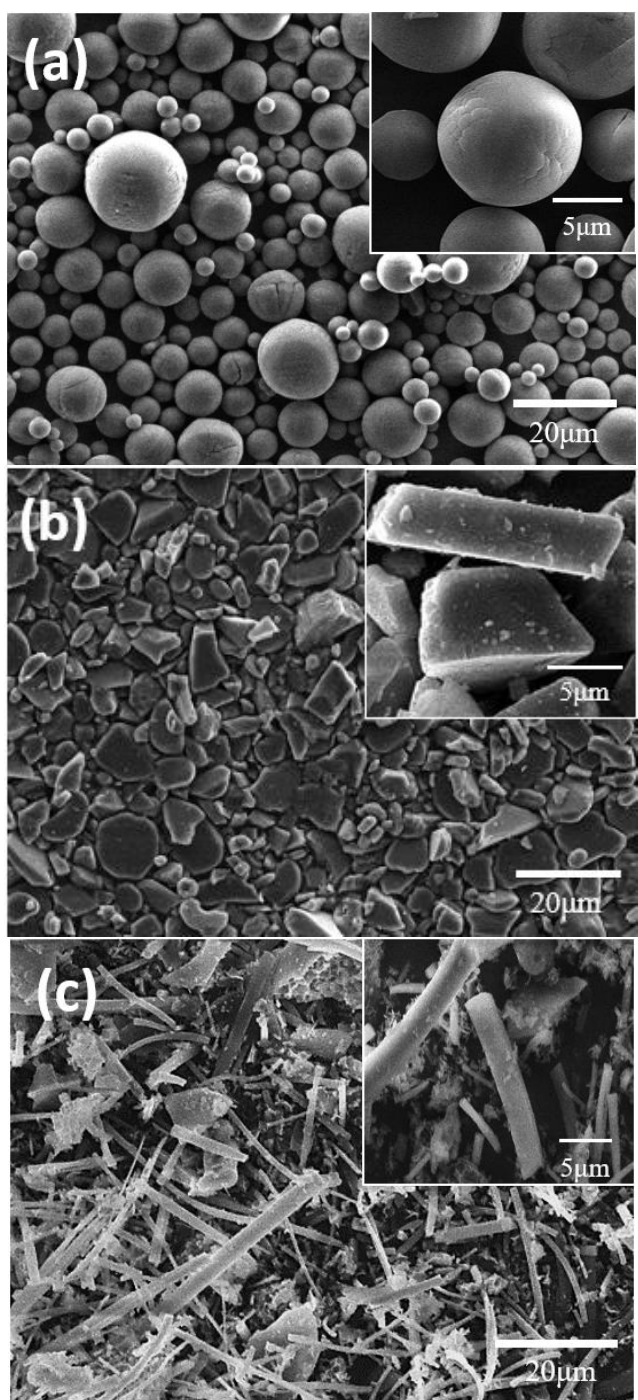
Figure 2. Scanning electron micrographs of different shapes of aluminum oxide (Al 2 O 3 ) powder. ( a ) Sphere, ( b ) plate, and ( c ) fiber.